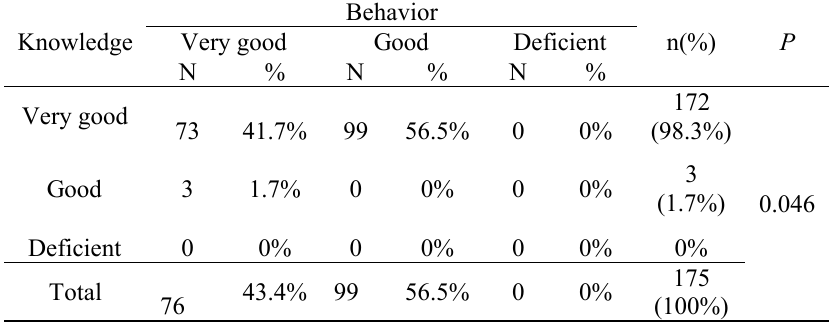
Table 6 Analysis of the correlation between knowledge and behaviour on group B